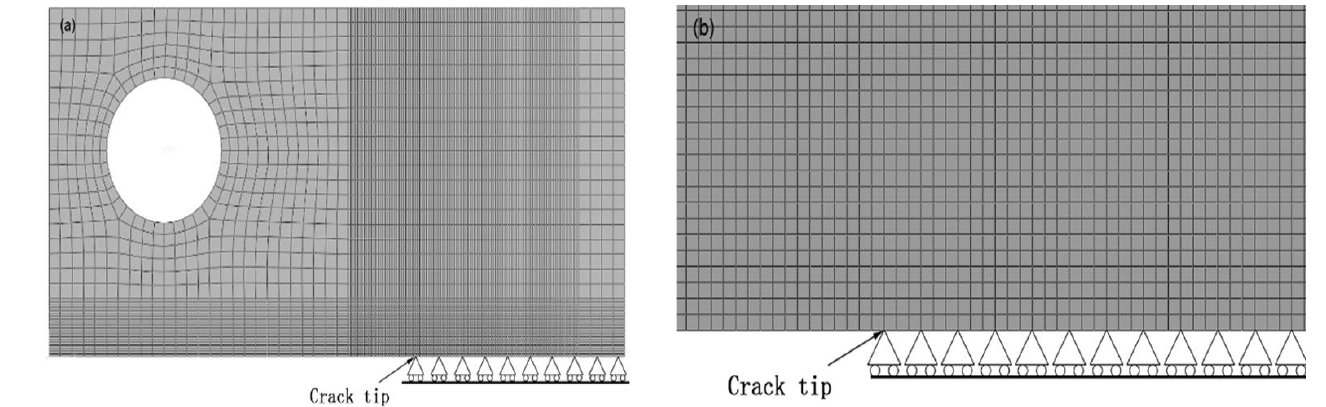
Figure 4. The FE meshes of the whole CT specimen ( a ) and local meshes at the crack tip ( b ).